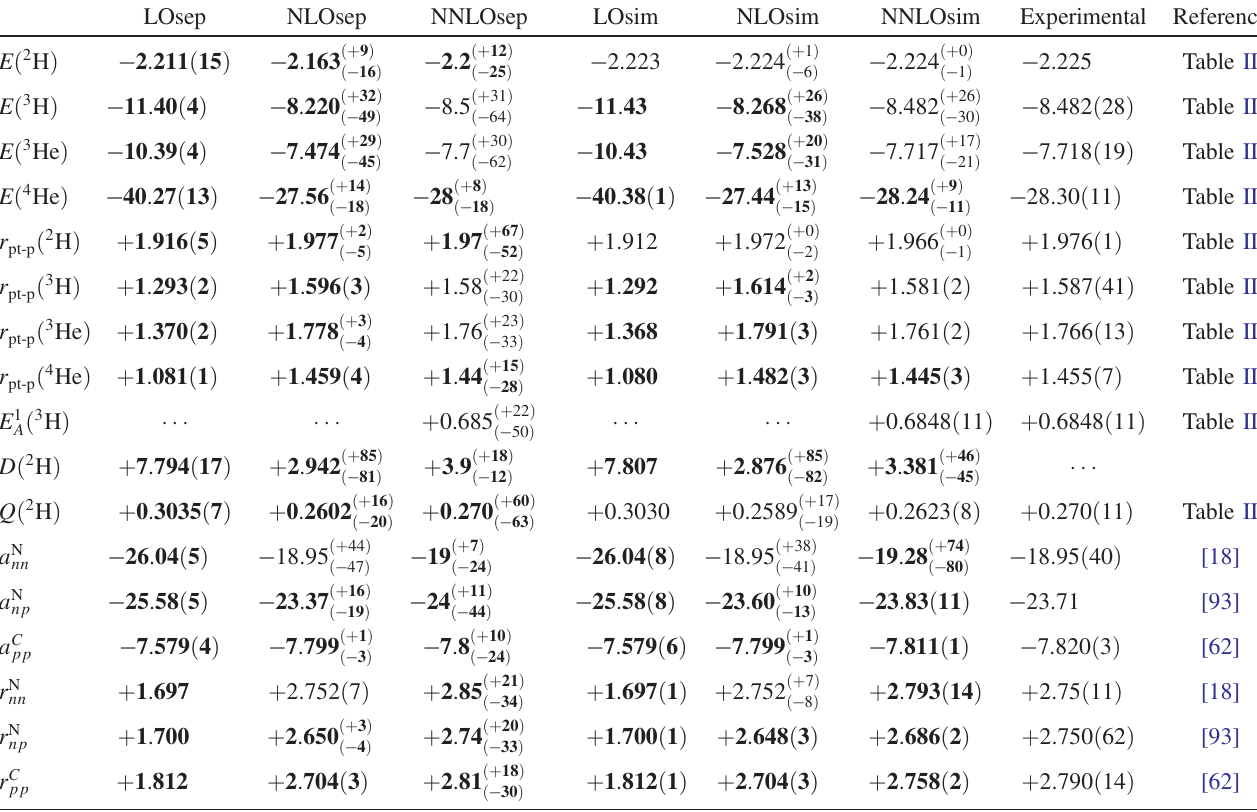
TABLE IV. Statistical uncertainties propagated from the NN , NNN , and π N LECs to the ground-state energies (in MeV) and radii (in fm) for A ≤ 4 nuclei, the deuteron D-state probability D ð 2 H Þ (in percent) and quadrupole moment Q ð 2 H Þ (in e fm 2 ) and effective- range observables for the 1 S 0 channel (in fm). The bold emphasis indicates that the corresponding result is a prediction. Asymmetrical errors are due to the quadratic dependence of the observables on the LECs. The error bars on the experimental values for bound-state observables include both experimental and method uncertainties as detailed in Table